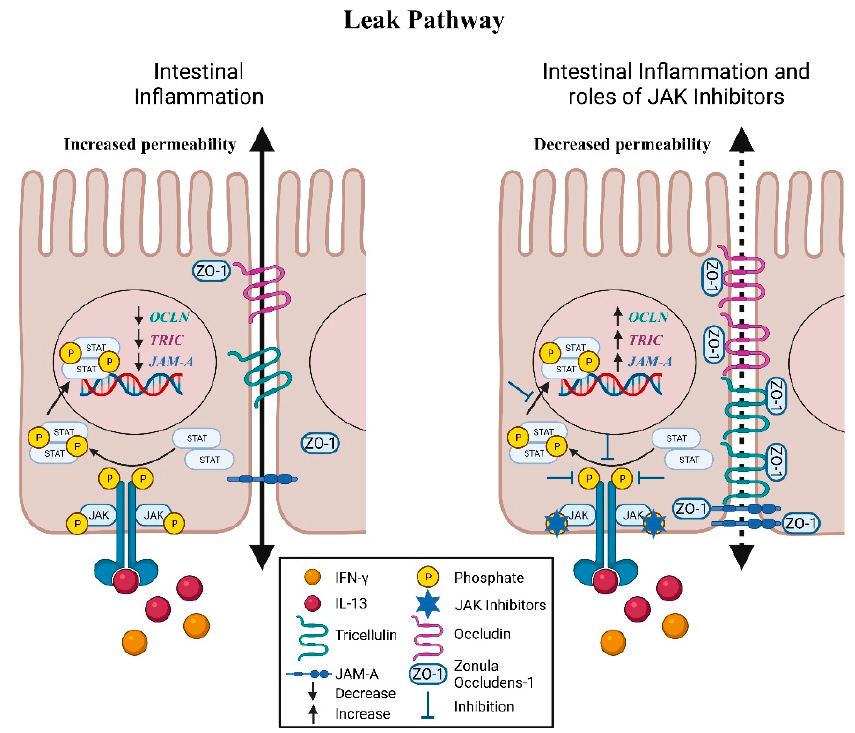
Figure 3. JAK-STAT regulation of intestinal permeability: Leak Pathway. The leak pathway is associated with altered expression and localization of ZO-1, occludin, and tricellulin resulting in lower levels of these proteins at the tight junction. Expression of JAM-A is also downregulated through the JAK-STAT pathway. JAK1 and JAK2 inhibitors prevented the decrease in tricellulin expression by IL-13. Furthermore, with tofacitinib treatment, the reduced expression and mislocalization of ZO-1 and occludin induced by IFN- γ are mostly reversed. JAM-A levels were also corrected by tofacitinib. These illustrations were made using BioRender. (JAK: Janus Kinase, STAT: Signal Transducer and Activator of Transcription, OCLN: Occludin Gene, TRIC: Tricellulin Gene, JAM-A: Junctional Adhesion Molecule-A Gene).